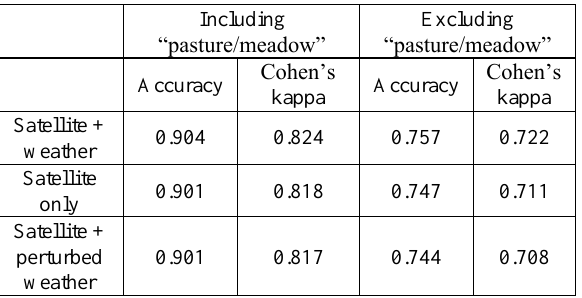
Table 5. Overall accuracy and Cohen’s kappa obtained on the testing subset using a Transformer model trained with both satellite and weather data and only with satellite data. In the last row, the scores obtained perturbing the weather data of the testing subset with Gaussian white